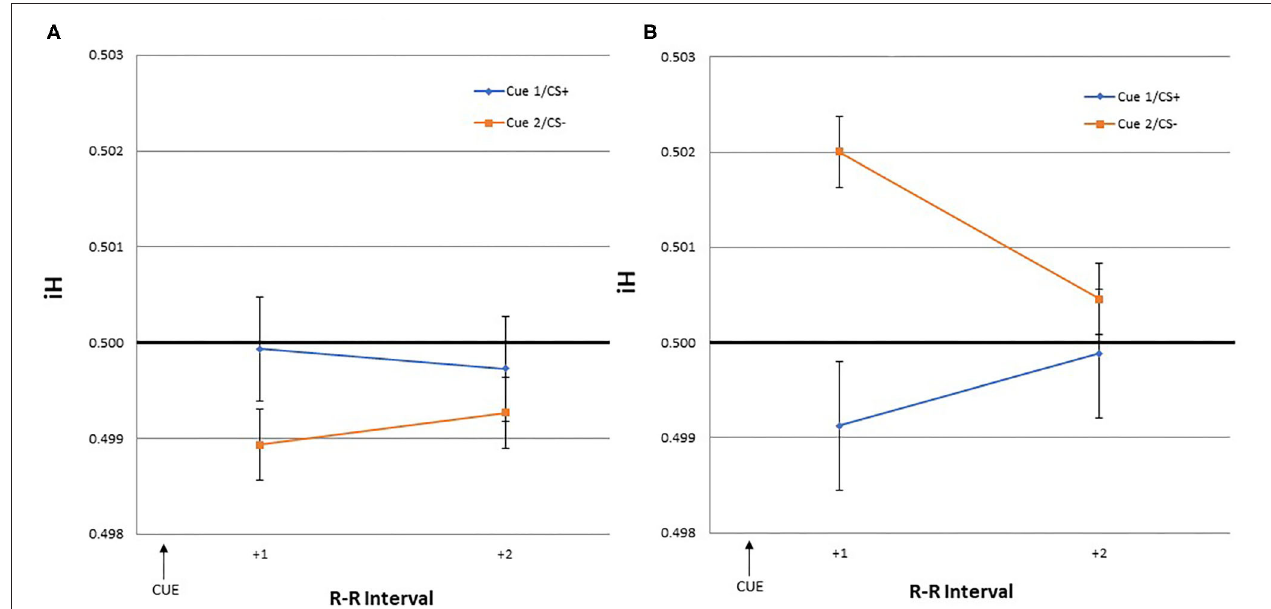
FIGURE 3 | The mean iH values and within-subject standard errors for the first and second interval after a cue onset [Cue 1/CS + (blue) or Cue 2/CS– (orange)] during the (A) training and (B) test phase.